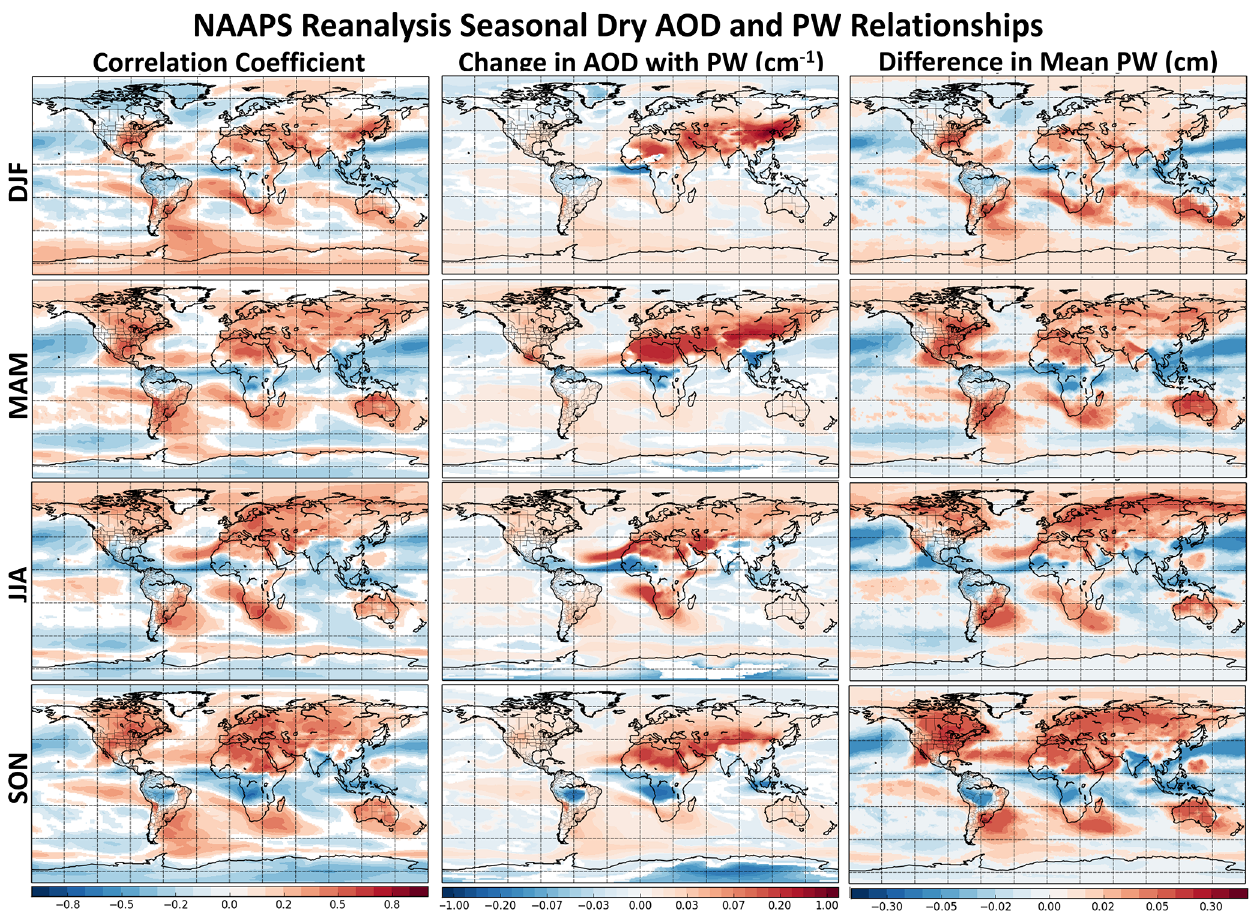
Figure 14. Seasonal dry AOD and PW relationships based on the NAAPS-RA shown as (1) correlation coefficients between daily-averaged dry AOD and PW (non-zero values are statistically significant at the 95% level), (2) Theil–Sen regression slopes (change in AOD with PW) between daily-averaged dry AOD and PW (in cm − 1 ) at locations where the correlation is statistically significant, and (3) the statistically significant difference in mean PW (cm) between the PW distribution associated with high dry AOD events ( > 1 standard deviation above mean) and the PW distribution for all AOD values. Red regions indicate a positive relationship between dry AOD and PW, and blue regions indicate a negative